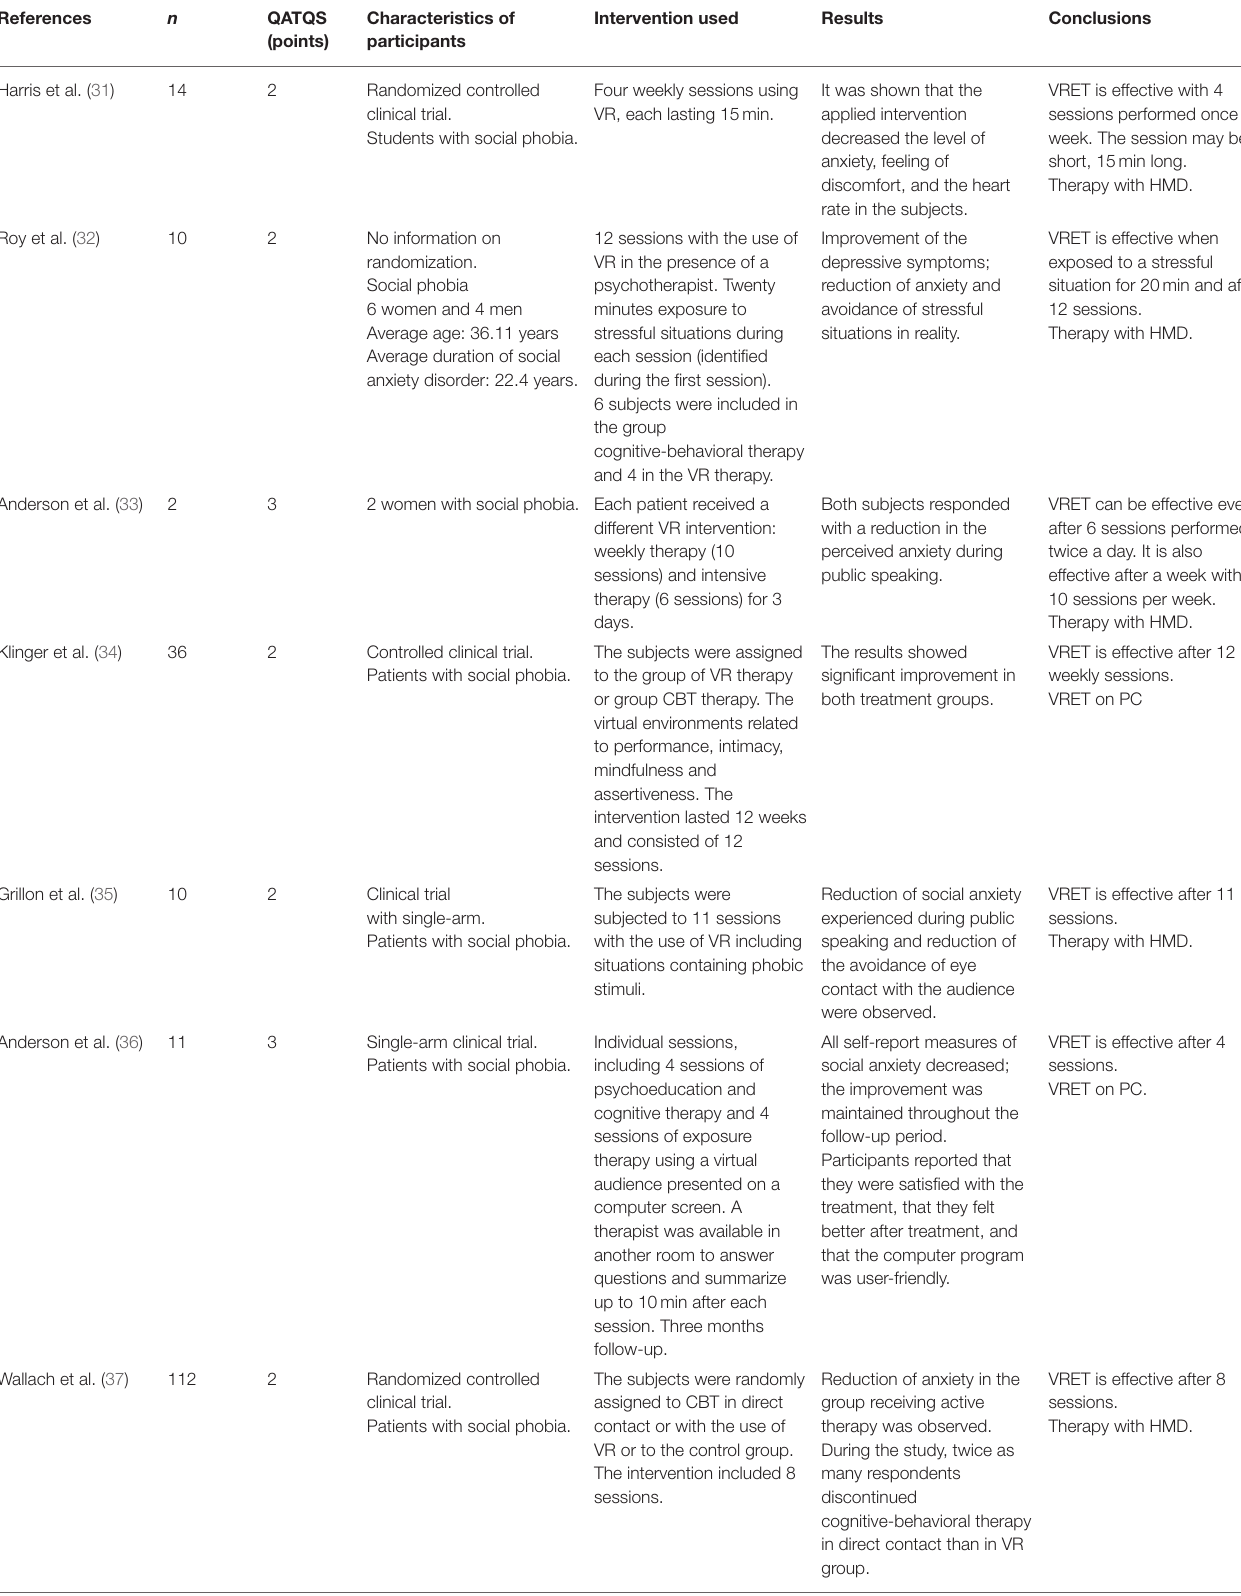
TABLE 2 | Studies on the use of VR exposure therapy in social